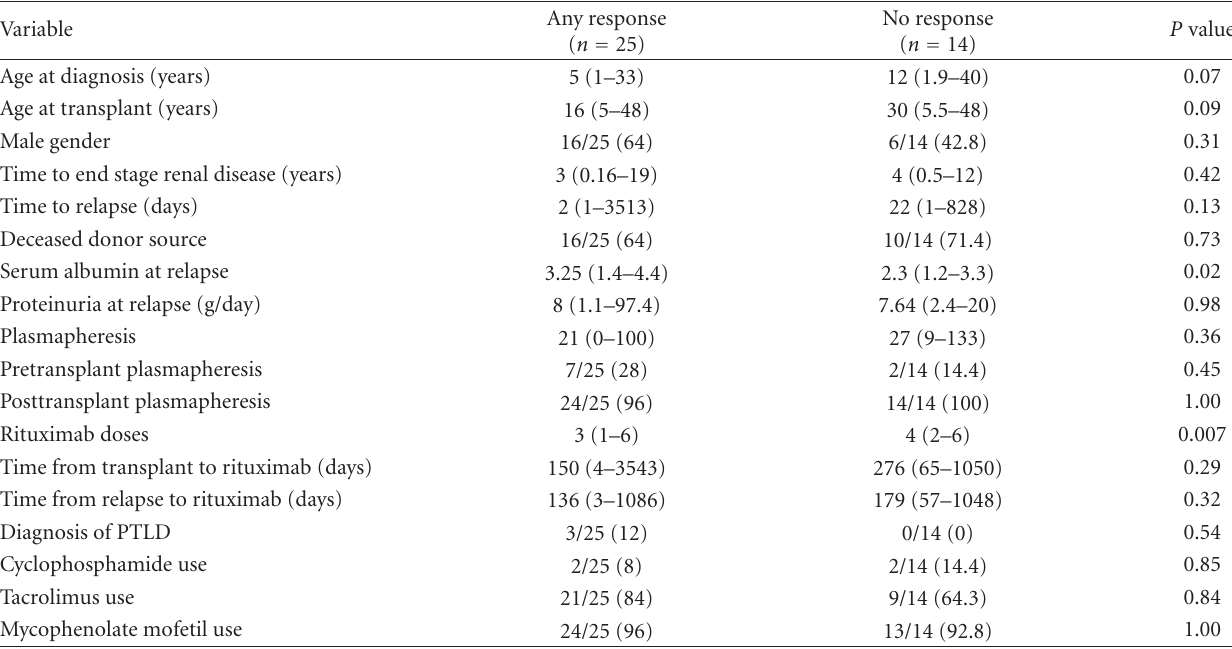
Table 2: Univariate analysis for the 2-outcome model of any response versus no response to rituximab therapy. Values expressed as median (range) or proportion